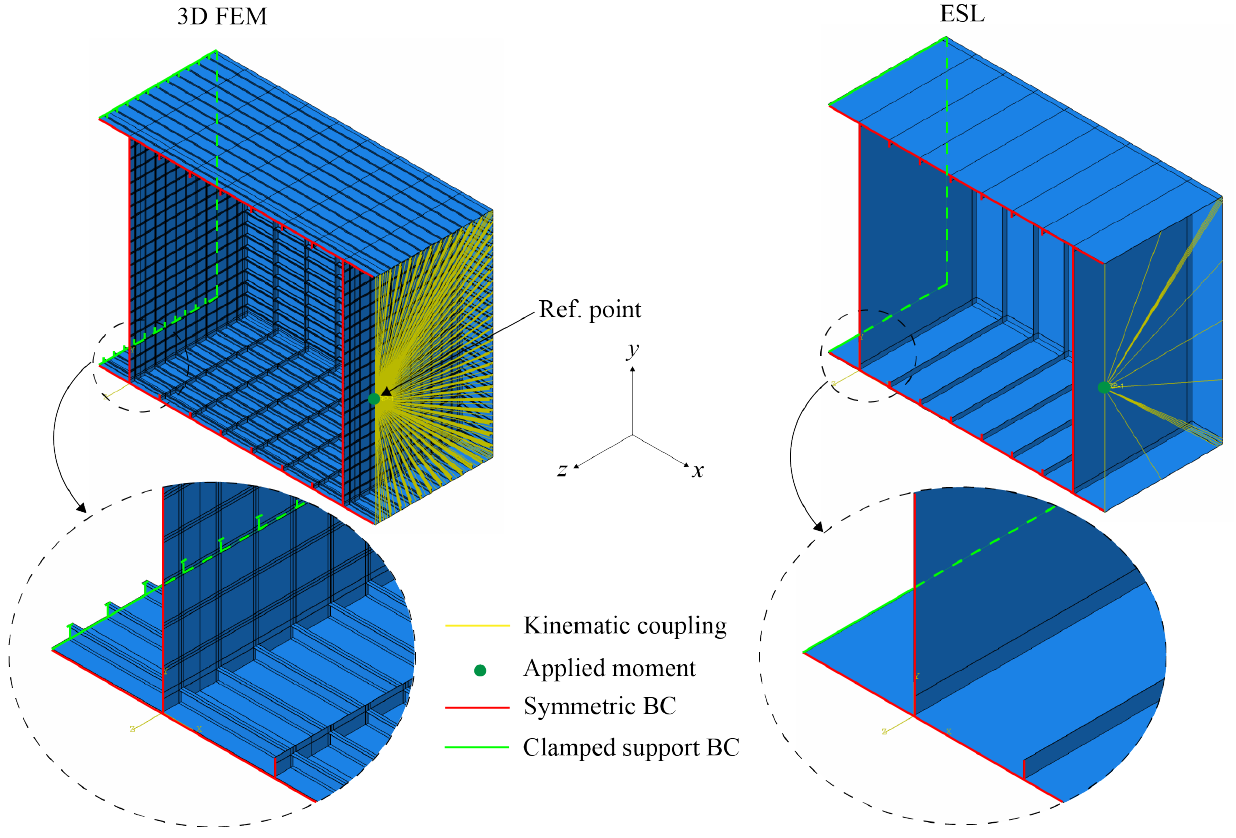
Figure 4. Boundary condition applied in 3D FEM and ESL of box